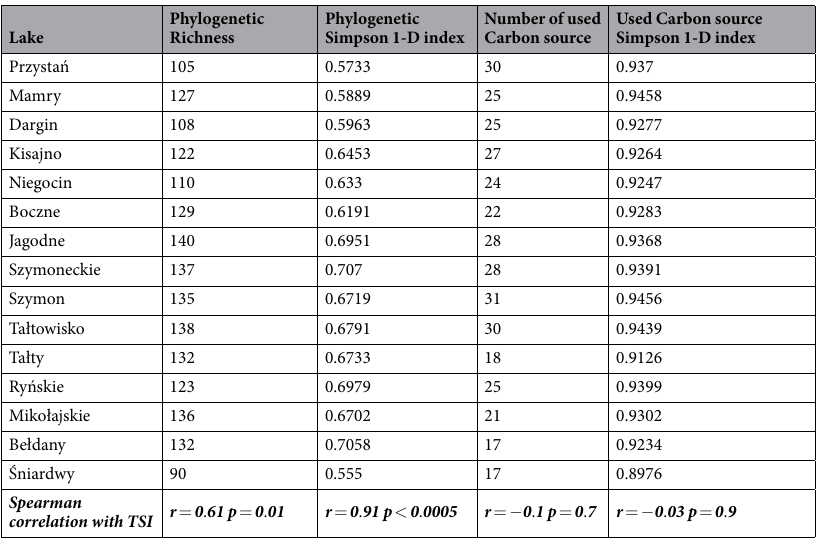
Table 3. Richness (number of taxa or used carbon sources) and Simpson’s diversity index characterizing the studied lakes. In the case of taxonomic diversity at the family level, OTU richness and diversity were positively correlated with the mean TSI of the studied lakes. In the case of metabolic fingerprinting, we did not find a significant correlation between the TSI and the number of bacterial carbon sources (richness equivalent) or Simpson’s diversity index.